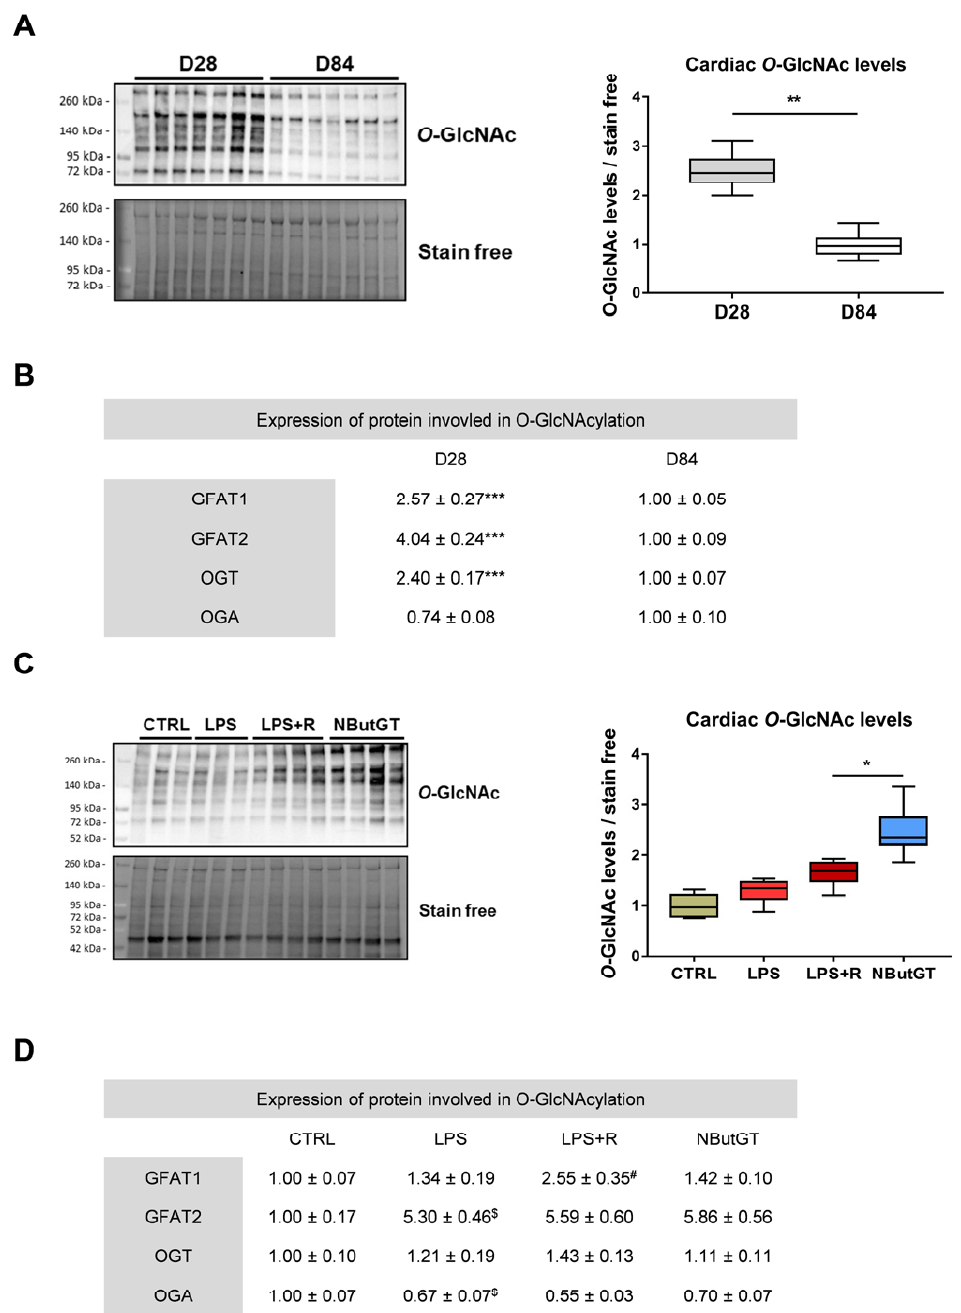
Figure 1. Impact of aging and septic shock on O -GlcNAcylation. Evaluation by Western blot of O-GlcNAcylation levels of cardiac proteins ( A ) and involved protein levels ( B ) in animals aged 28 and 84 days (D28 (young) and D84 (adult). Statistical significance was assessed by Mann–Whitney test (**: p < 0.01; ***: p < 0.001). Evaluation by Western blot of O-GlcNAcylation levels of cardiac proteins ( C ) and involved protein levels ( D ) in CTRL, LPS, LPS+R and NButGT group. Statistical significance was assessed by Kruskal–Wallis test with uncorrected Dunn’s post-test (*: p < 0.05; # : p < 0.05 vs. LPS; $ : p < 0.05 vs. CTRL). Quantification was performed in relation to stain free. Results are expressed as mean ± SEM. CTRL: control group, LPS: i.v. injection of LPS (20 mg/kg), LPS+R: subcutaneous ad-